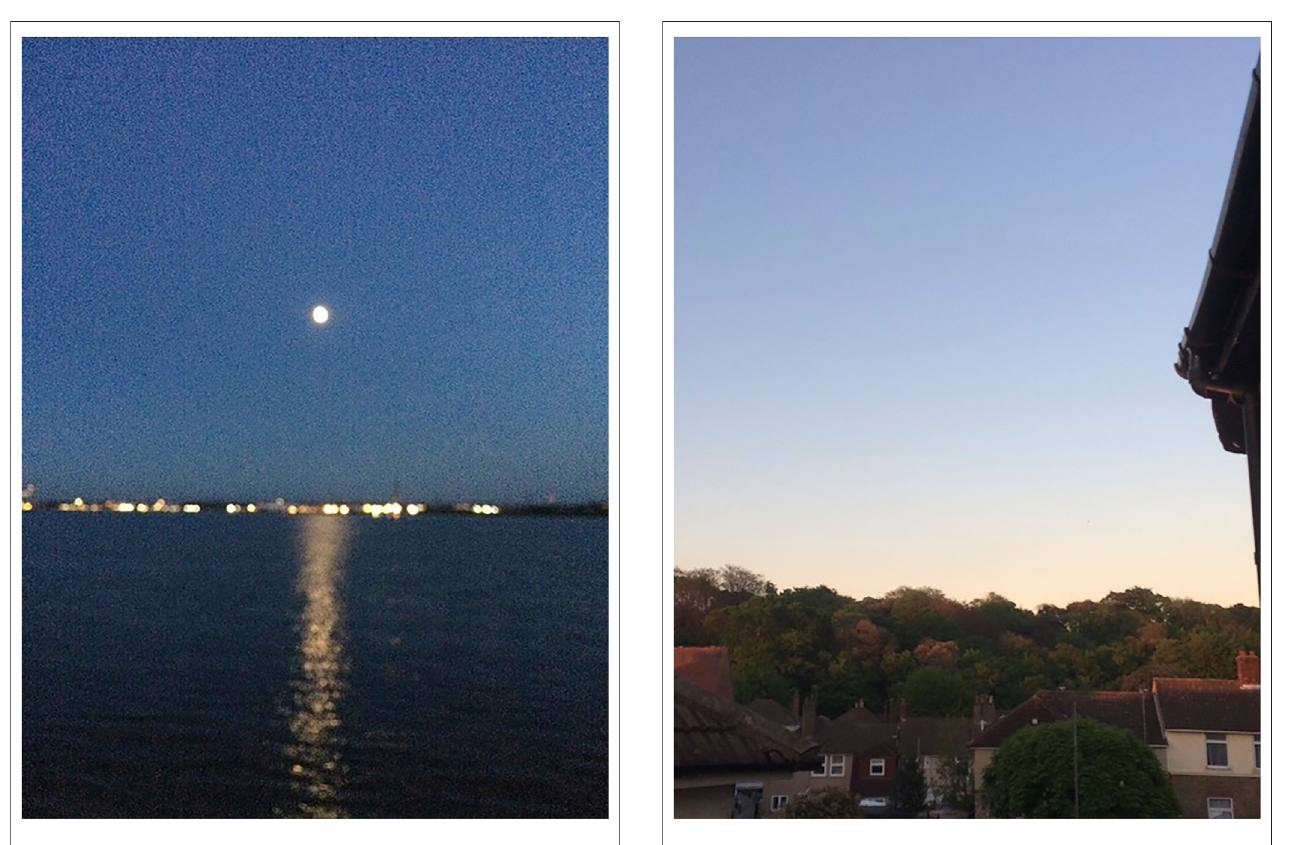
Frontiers in Human Dynamics |